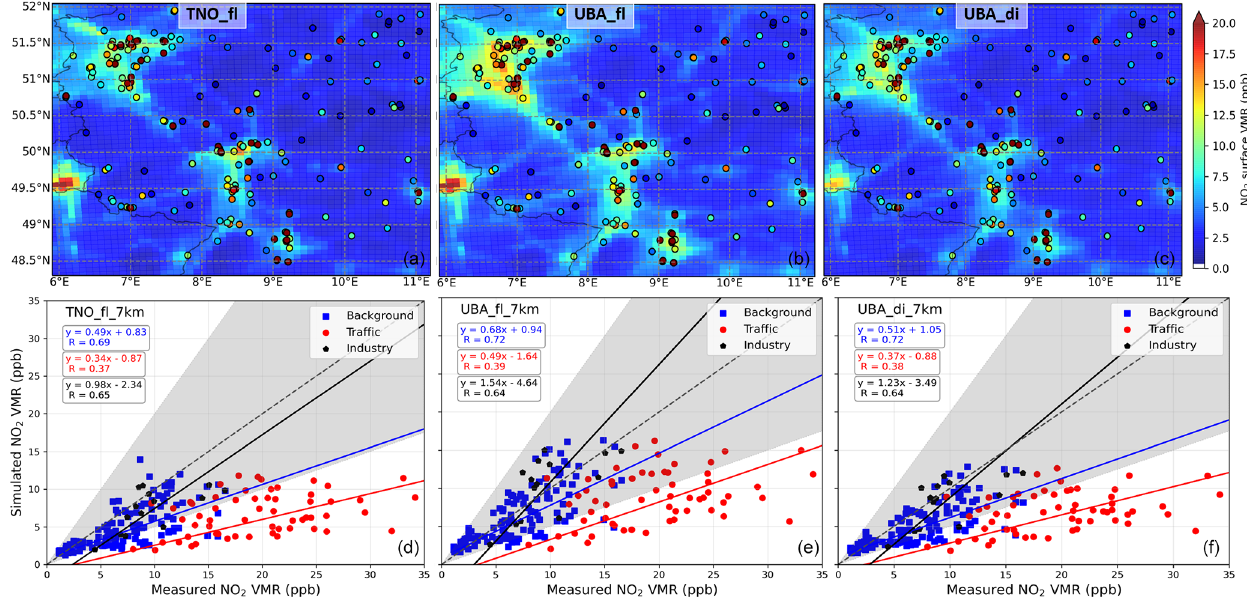
Figure C2. Same as Fig. 4 but for the CM07 set-up in the domain limited to that for CM02 boundaries.